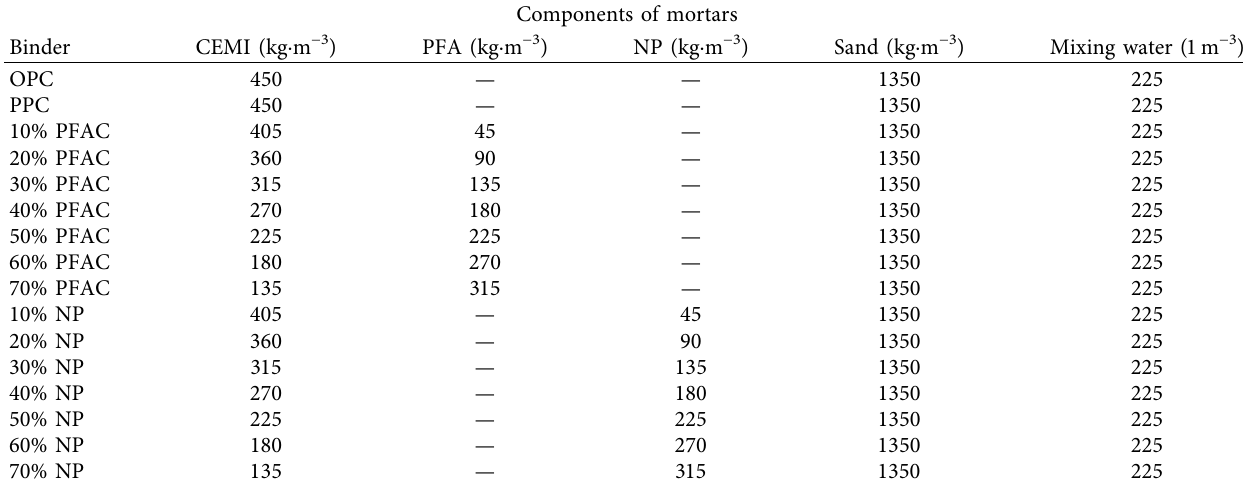
Table 2: Mixture proportions of